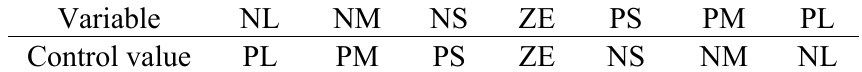
Table 1. Single Input Single Output (SISO) Rule Inference.